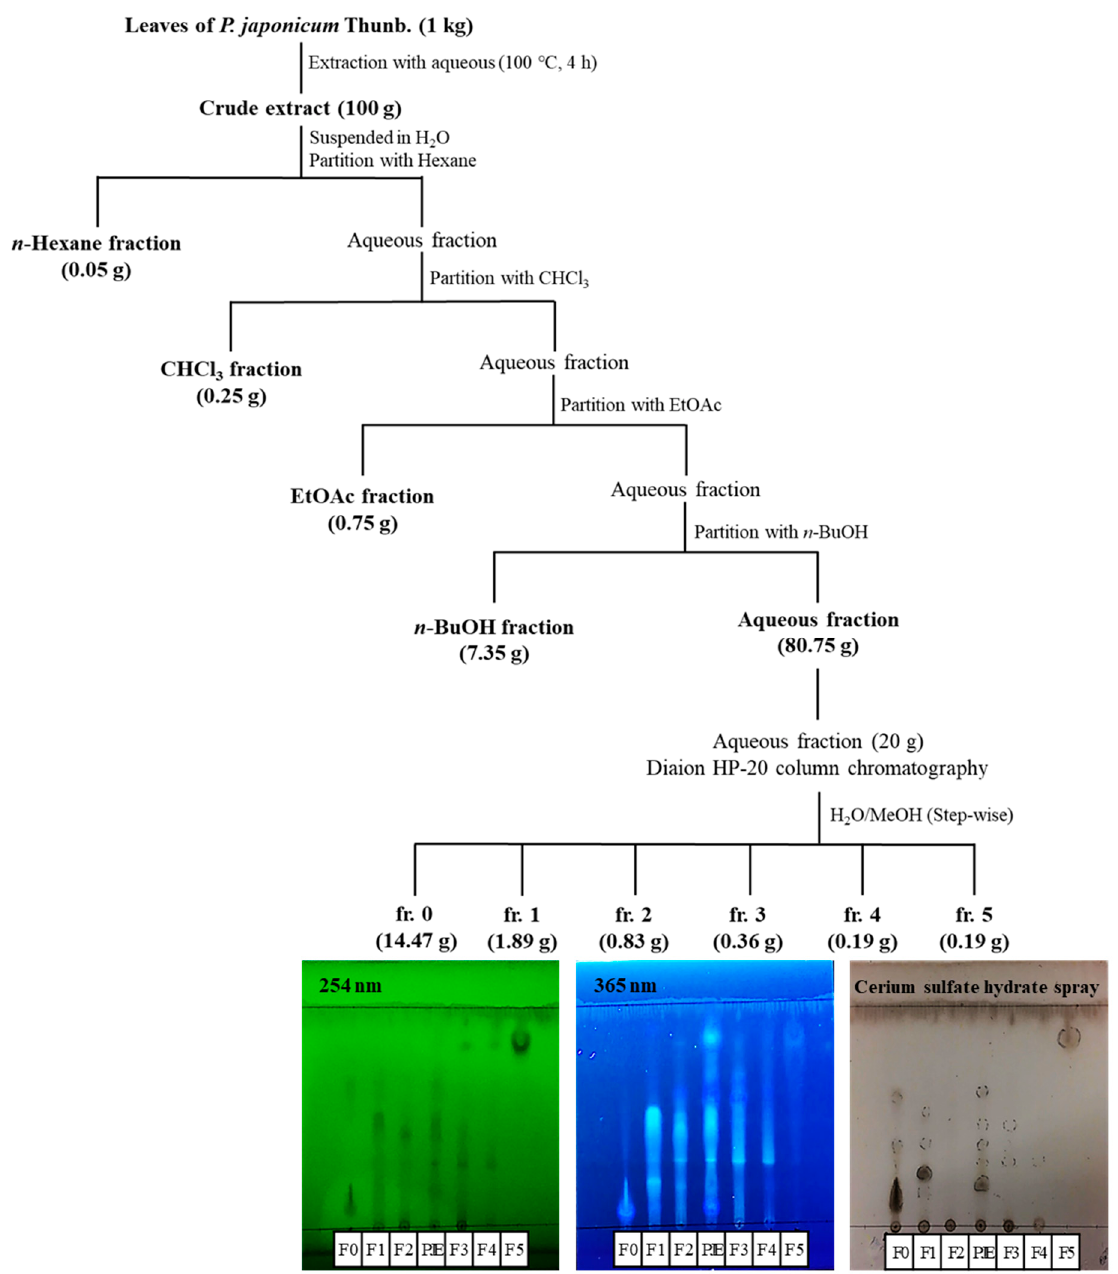
Figure 1. Scheme of PJE fractionation by solvent-solvent extraction and open column chromatography. TLC analysis images are also presented.